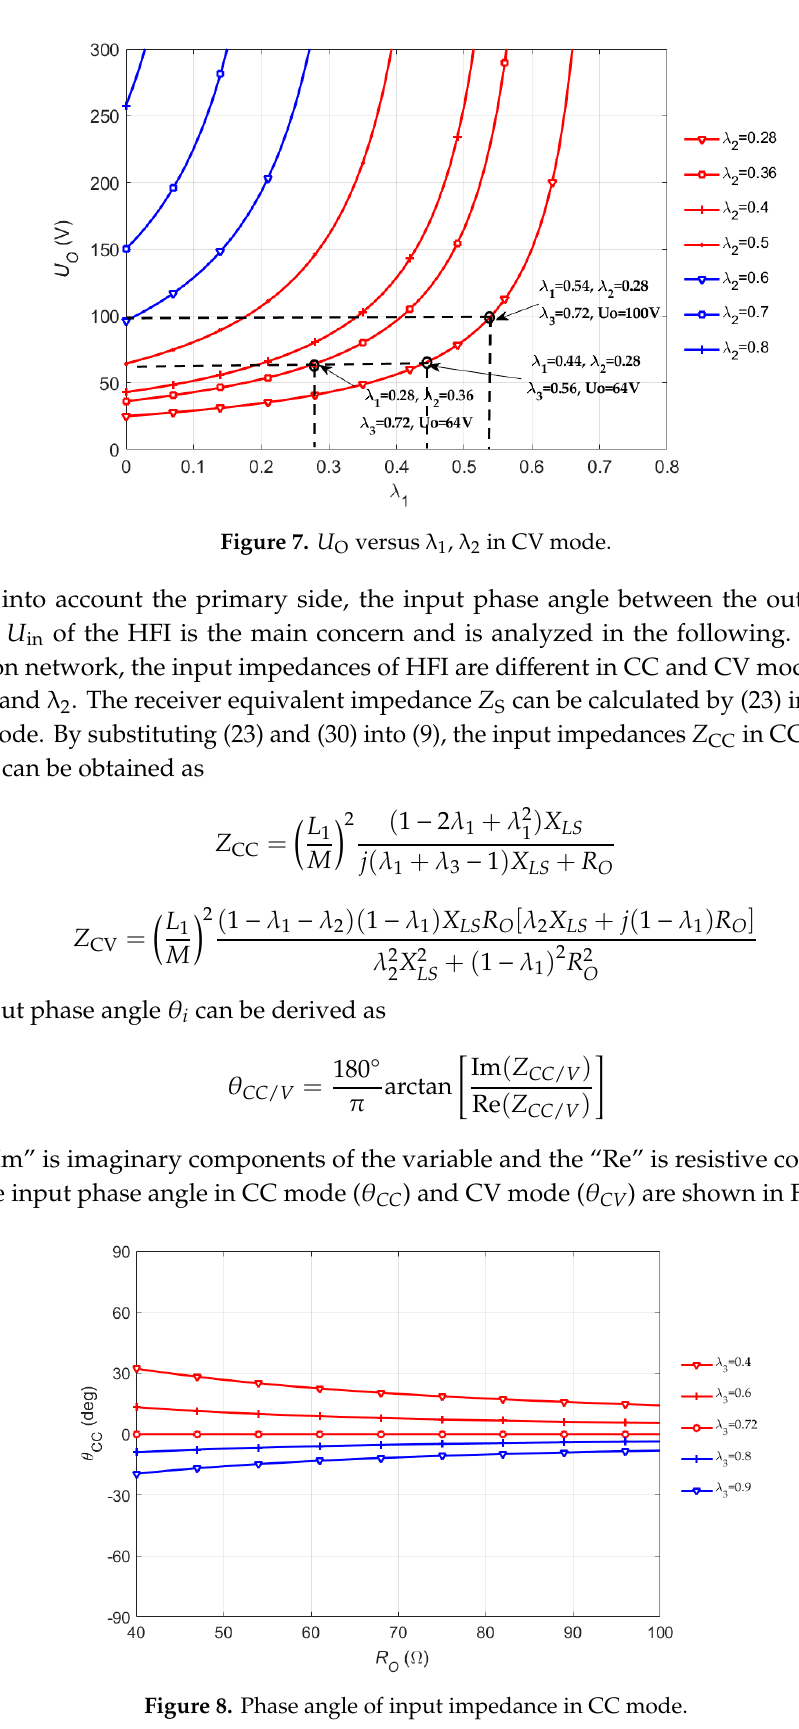
Figure 9. Phase angle of input impedance in CV mode. According to (24), the constant current output can make the secondary impedance pure resistance by the change of λ 3 . From Figure 8, when λ 3 equals 0.72 (marked as λ 3_R ), no matter what the values of λ 1 and λ 2 are, the input impedance is pure resistance, which means no reactive power in the IPT system. The input impedance of the HFI is inductive when λ 3 is less than λ 3_R and capacitive when λ 3 is greater than λ 3_R . Additionally, it is also shown that the phase angle decreases with the increase of load. The phase angle of the IPT system in CV mode is shown in Figure 9. The input impedance cannot be pure resistance. When λ 2 equals 0.72 (marked as λ 2_R ), the phase difference is 90 degrees. The input impedance of the HFI is inductive when λ 2 is less than λ 2_R and capacitive when λ 2 is greater than λ 2_R . The larger the difference between λ 2 and λ 2_R , the smaller phase angle between the output current I in and voltage U in of the HFI. Hard switching will occur and the switching loss will increase if the input impedance of the IPT system is capacitive. Therefore, λ 2 less than λ 2_R is adopted in practical application. According to the transconductance gain G CC (22) and the voltage gain G CV (28), the relationship between battery charging current, charging voltage, and source voltage of IPT system can be expressed as